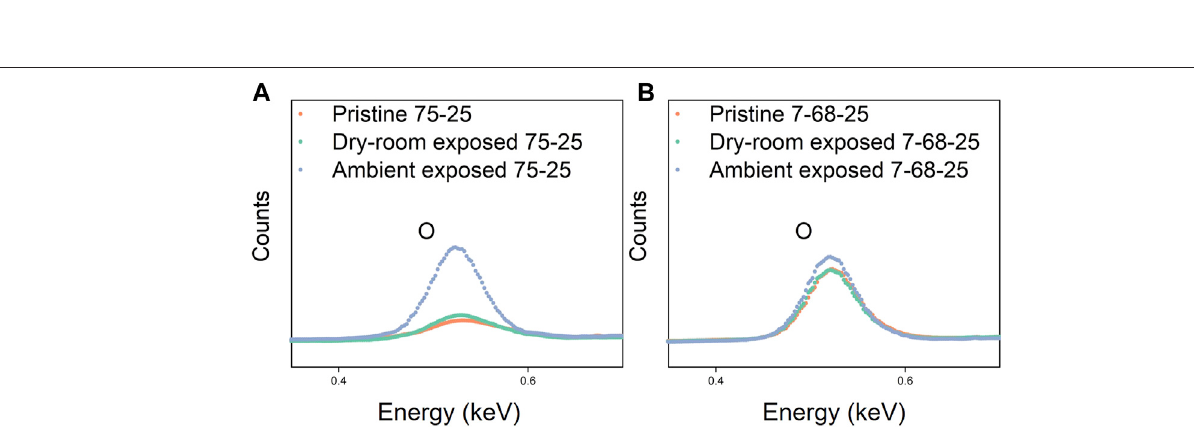
Frontiers in Energy Research |